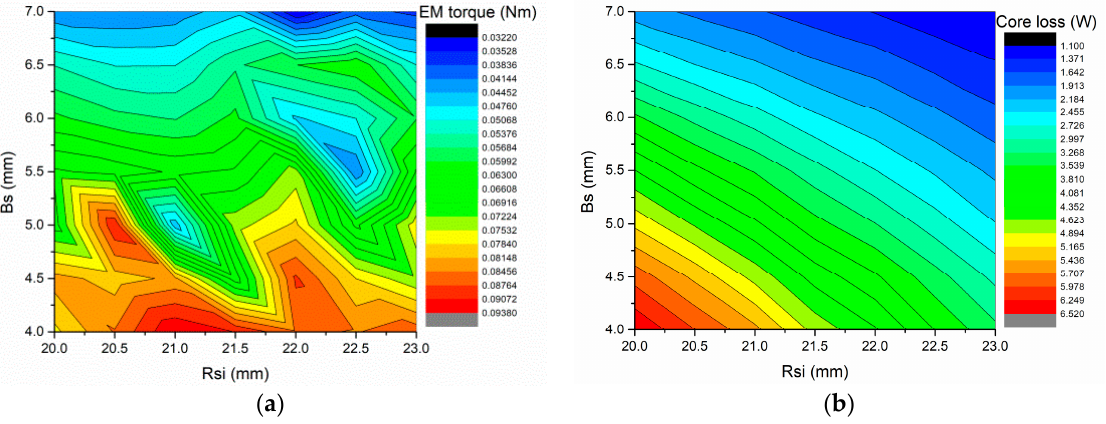
Figure 2. Optimization of the thickness of the stator wall and inner radius of the stator core: ( a ) EM torque; ( b ) Core loss.